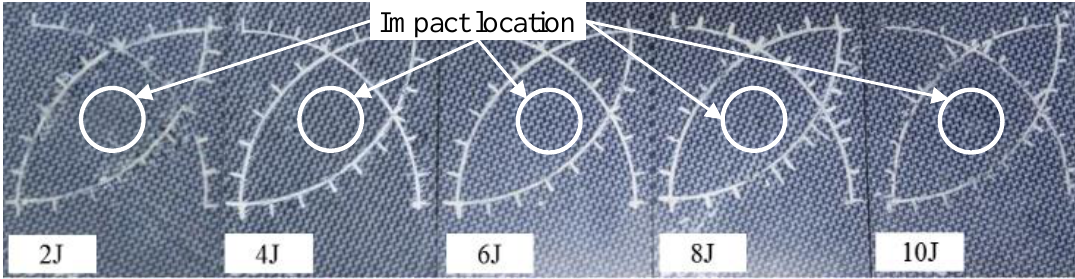
Figure 3. The CFRP specimens in this study .